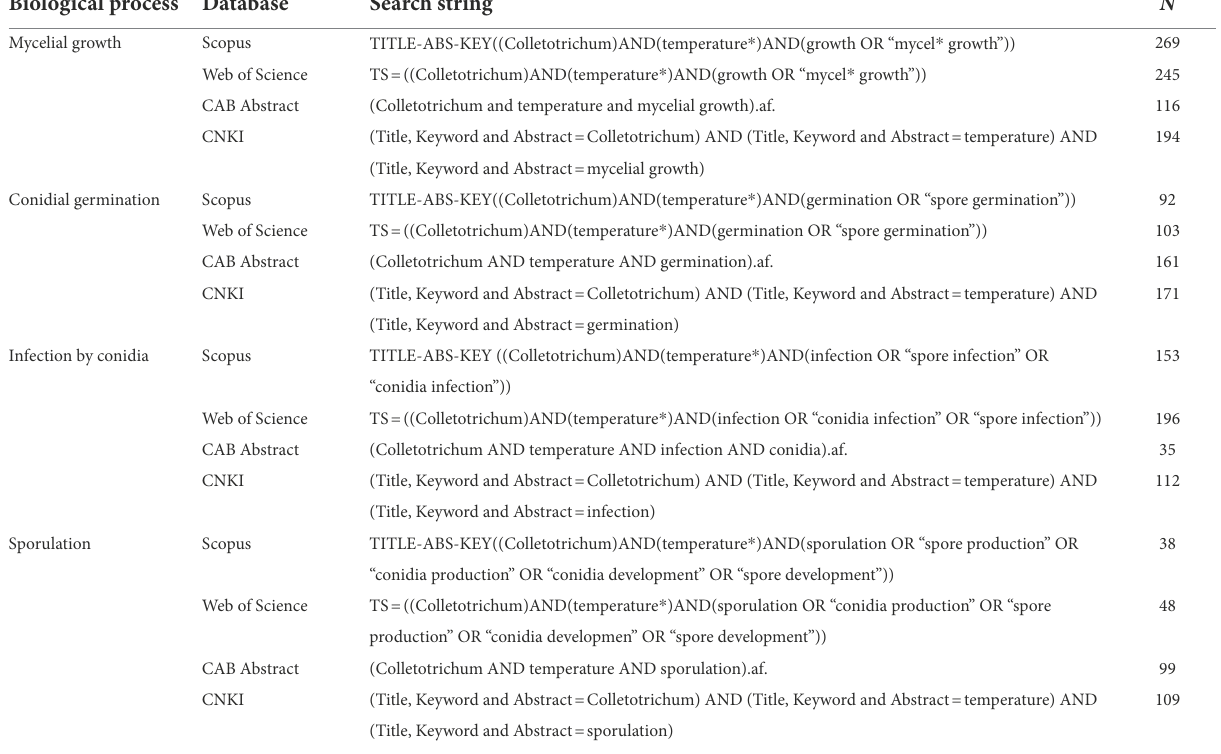
TABLE 1 Search strings for biological processes considered for the literature search in four databases and the corresponding number of papers found. Biological process Database Search string Mycelial growth